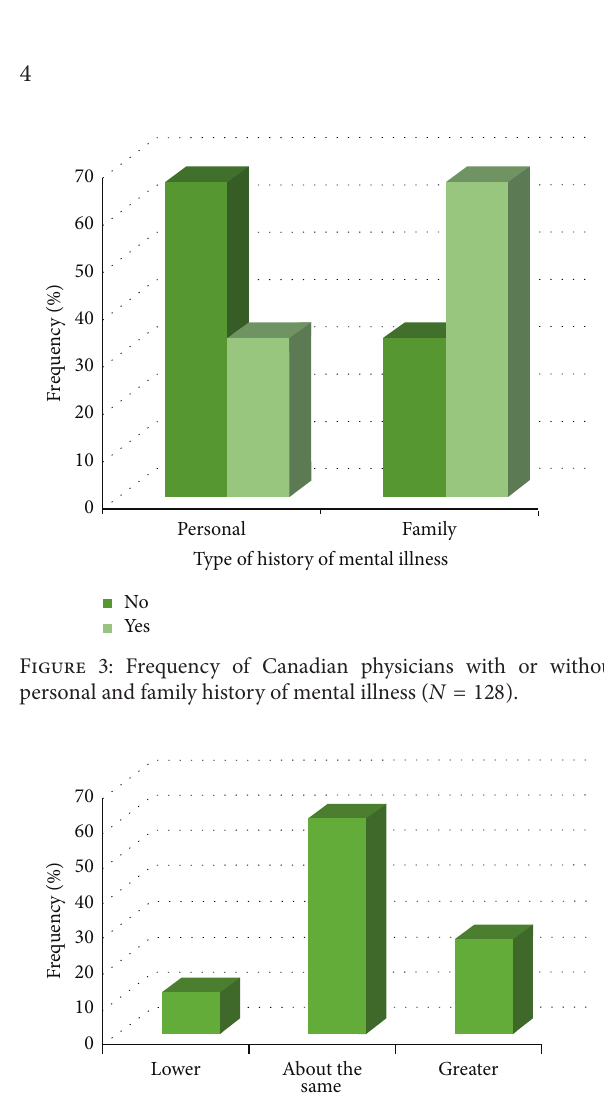
Figure 4: Canadian physicians divided by their estimation of the incidenceofmentalillnessamongstphysiciansrelativetothegeneral population ( 𝑁 = 127 ).